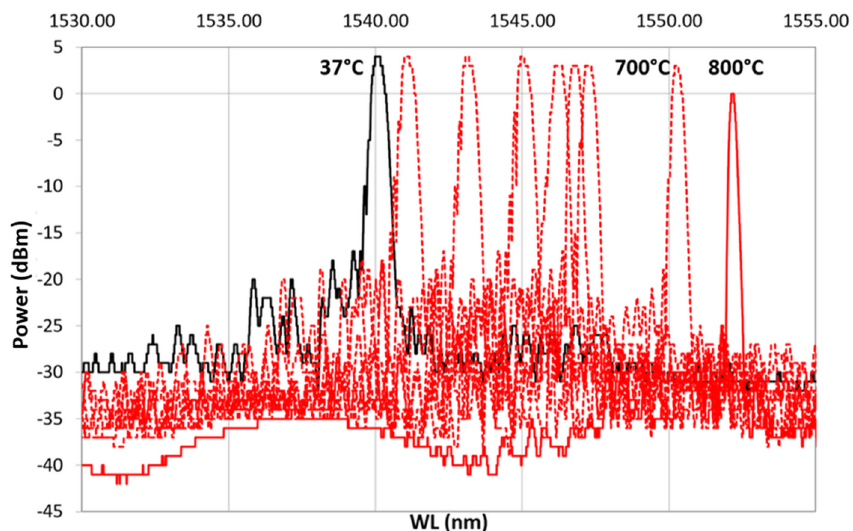
Figure 9. Heating ramp of the thermal cycle from 37 ◦ C, reference spectrum represented with a continuous black line, to 800 ◦ C, represented with a continuous red line.